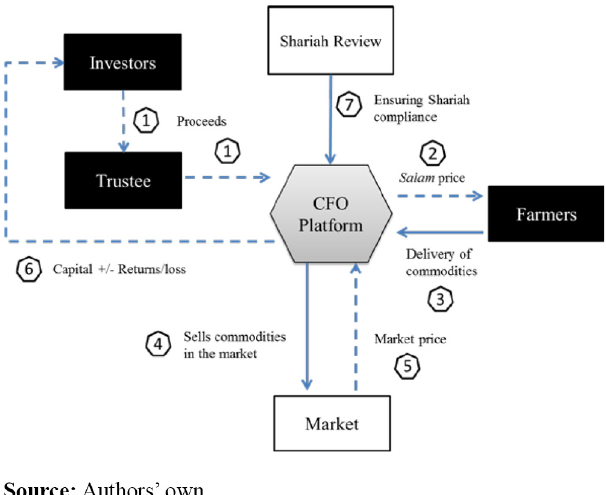
Figure 5. Proposed salam